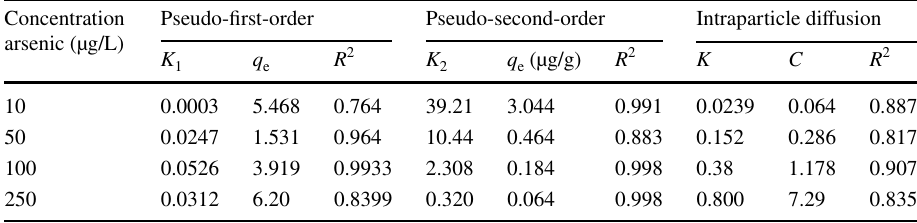
Table 2 Pseudo-second-order adsorption rate constants and qe values for different initial arsenic concentrations at pH 7